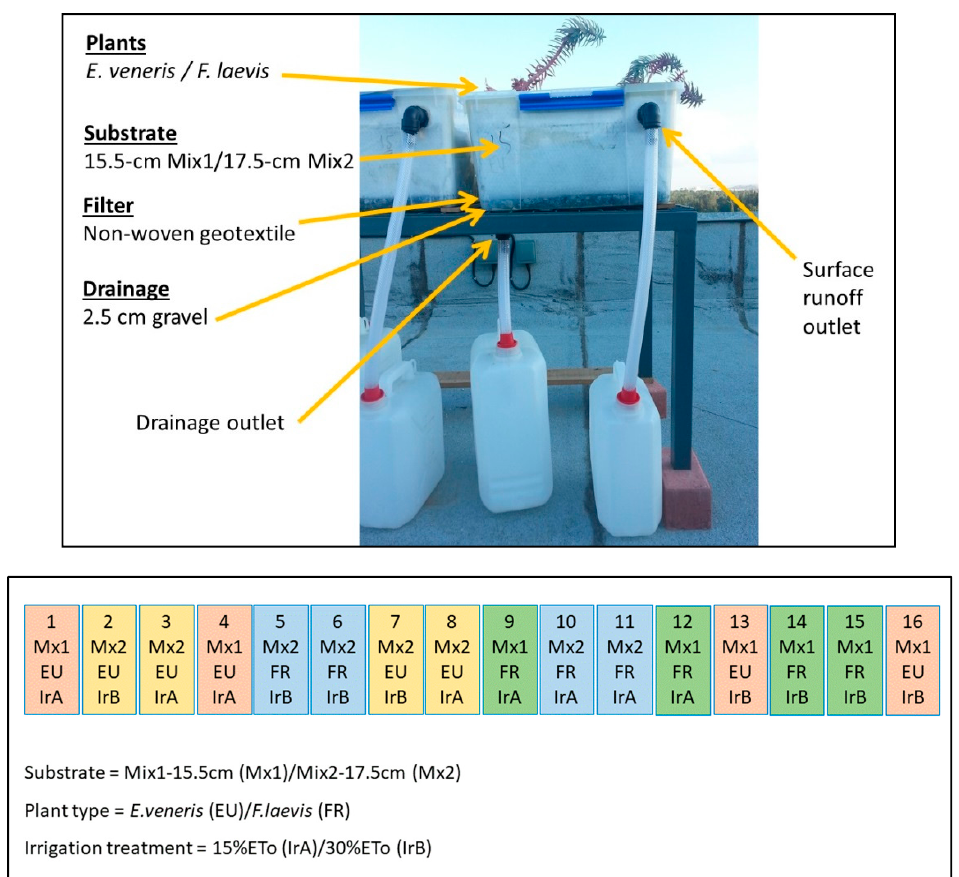
Figure 1. Setup of a green roof test bed ( top ), layout of the 16 green roof test beds ( bottom ).